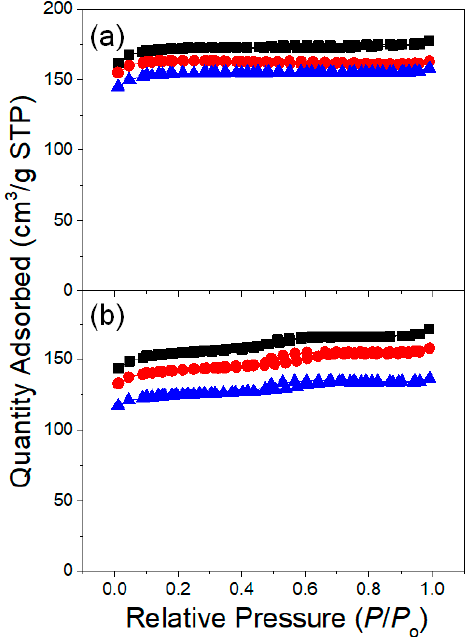
Figure 5. N 2 sorption isotherms of ( a ) XZ-Na and ( b ) XZ-K: (- ■ -) pristine zeolite, (- ● -) after 5 recycles, (- ▲ -) after 10 recycles.